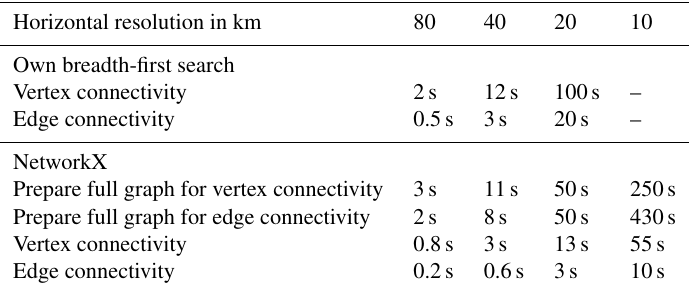
Table 3. Time required for different aspects of two alternative methods for different sizes of the triangular grid. The times are obtained from benchmarks on the DKRZ Levante supercomputing